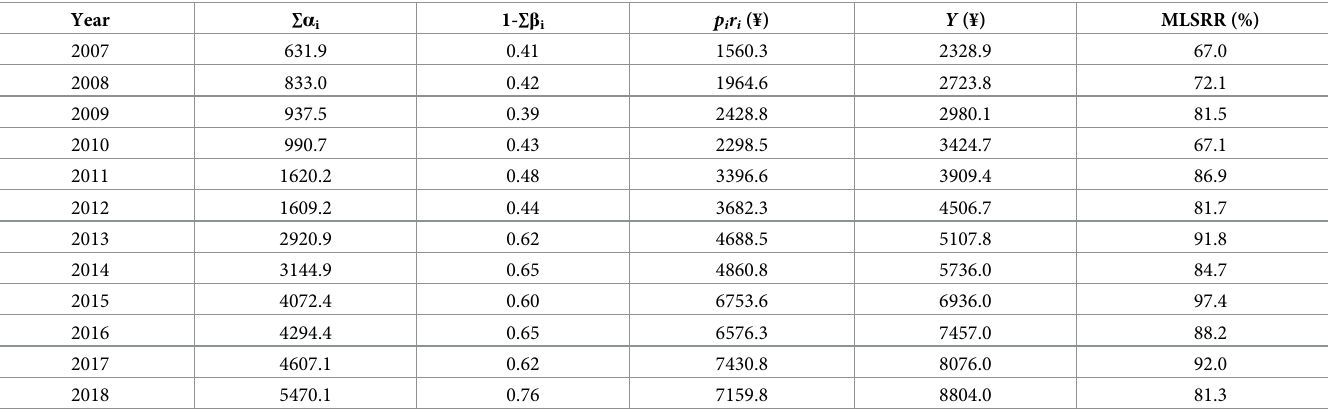
The actual replacement rate (ARR) for the elderly people is 24.2 percent in 2014, which is far lower than the modified living standards replacement rate (MLSRR) (84.7 percent) (Table 5). For the middle aged people, no matter which payment level they choose, the NRPS will not meet their basic living needs when they reach the retirement age (Fig 2). For example, even if a person aged 45 chooses the highest payment level (¥2,000 per year) and contributes to the Table 5. The results of basic consumption expenditure and modified living standards replacement rate (MLSRR) for the elderly from 2007–2016.